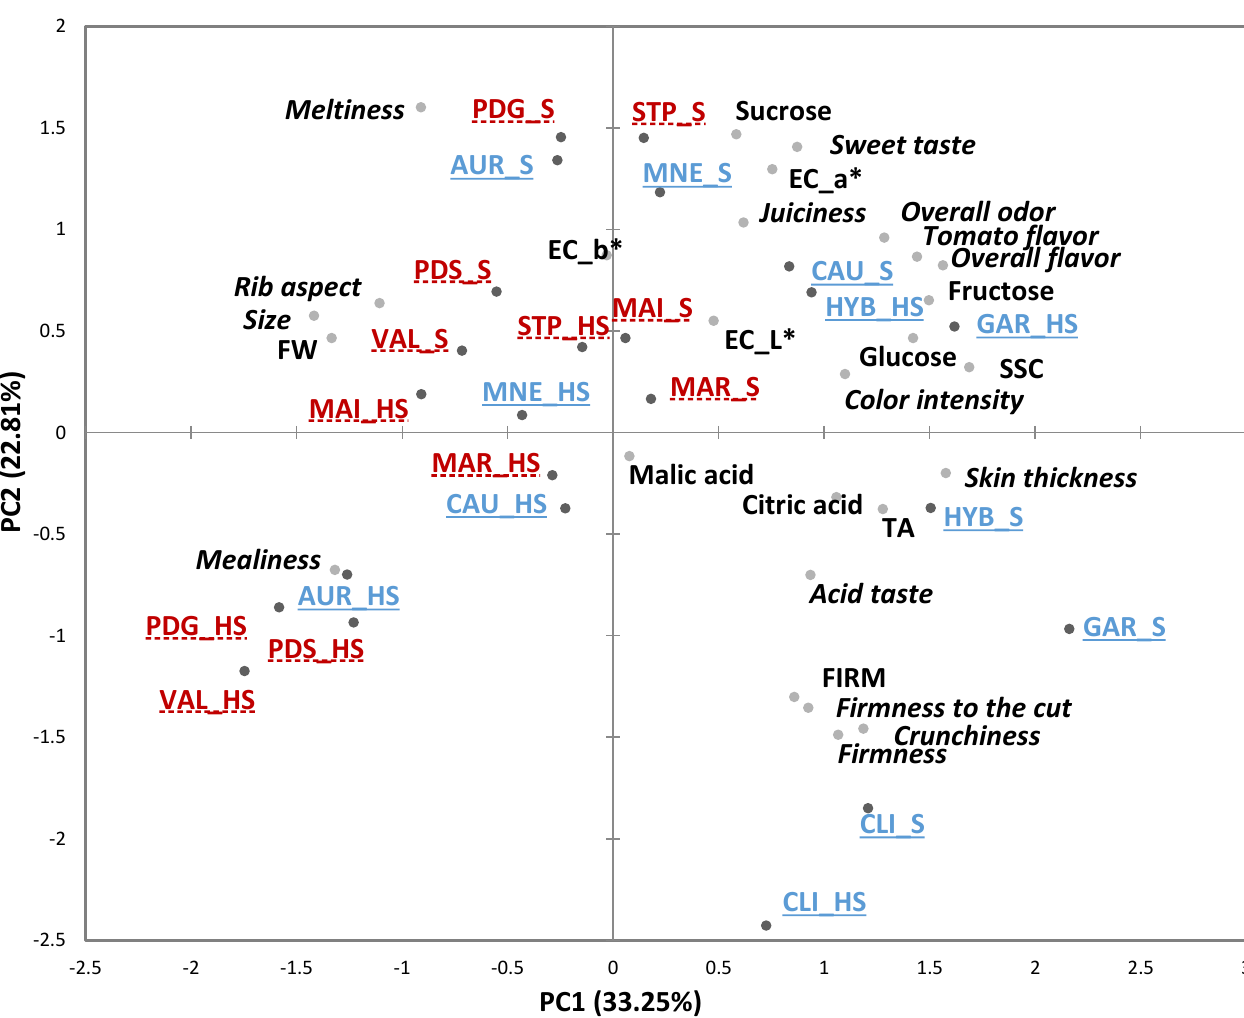
Figure 1. Principal component analysis (PCA) Bi-plot of the sensory and physicochemical parameters of the 12 tomato genotypes grown in Soil (S) and Soilless (HS) in France. Sensory descriptors are indicated in italics . Modern varieties are in blue, underlined with solid lines; Traditional varieties are in red, underlined with dashed lines. FW = fruit weight, FIRM = firmness (instrumental), SSC = soluble solids content, TA = titratable acidity. Product codes are listed in Table 1.